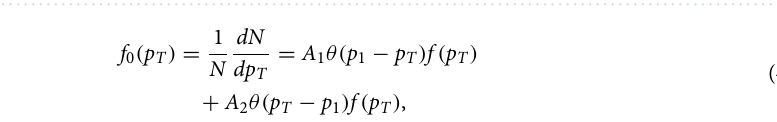
Figure 1. The transverse momentum ( p T ) spectra of ( a ) deutron, ( b ) anti-deutron and ( c ) triteron produced in | y | < 0.5 in different centrality classes in Au–Au collisions at 54.4 GeV. The symbols are the experimental data of the STAR Collaboration 56 and the curves are our fitting by using BGBW statistics. Each panel is followed by the ratio of the